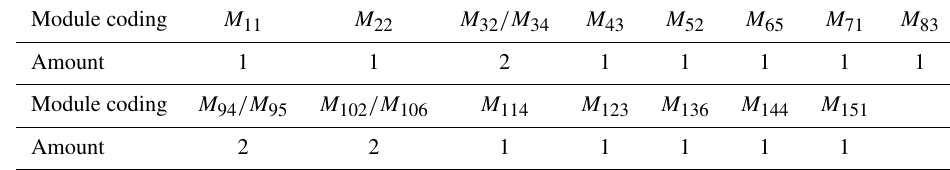
Table 9. Search results of the machine tool module.